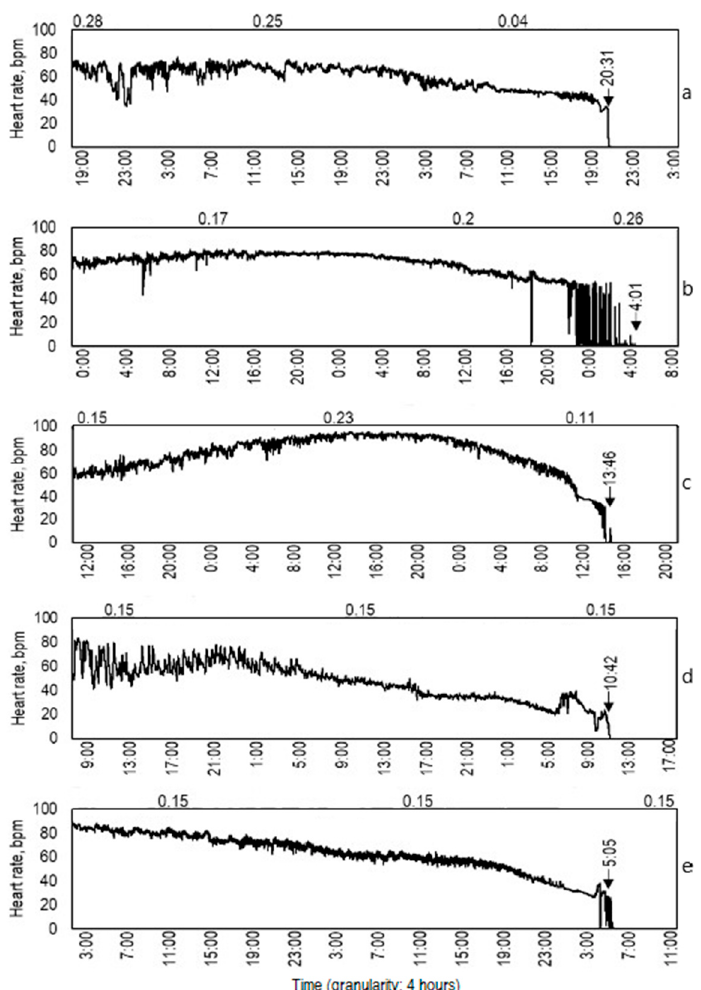
Figure 4. Examples of heart rate of five crayfish P. leniusculus two days before mortality occurred. The line indicates heart rate in beats per minute. Daily ClO 2 (mg L − 1 ) concentration are situated above the graphs, time of death is indicated by the vertical arrow.